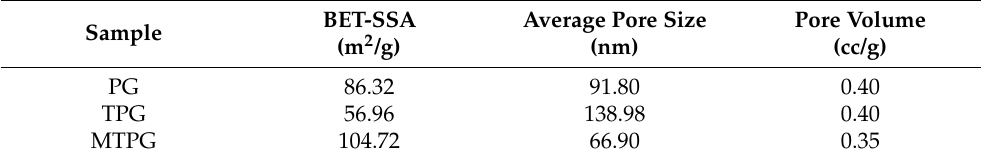
Table 1. Specific surface area, average pore size, and pore volume of the